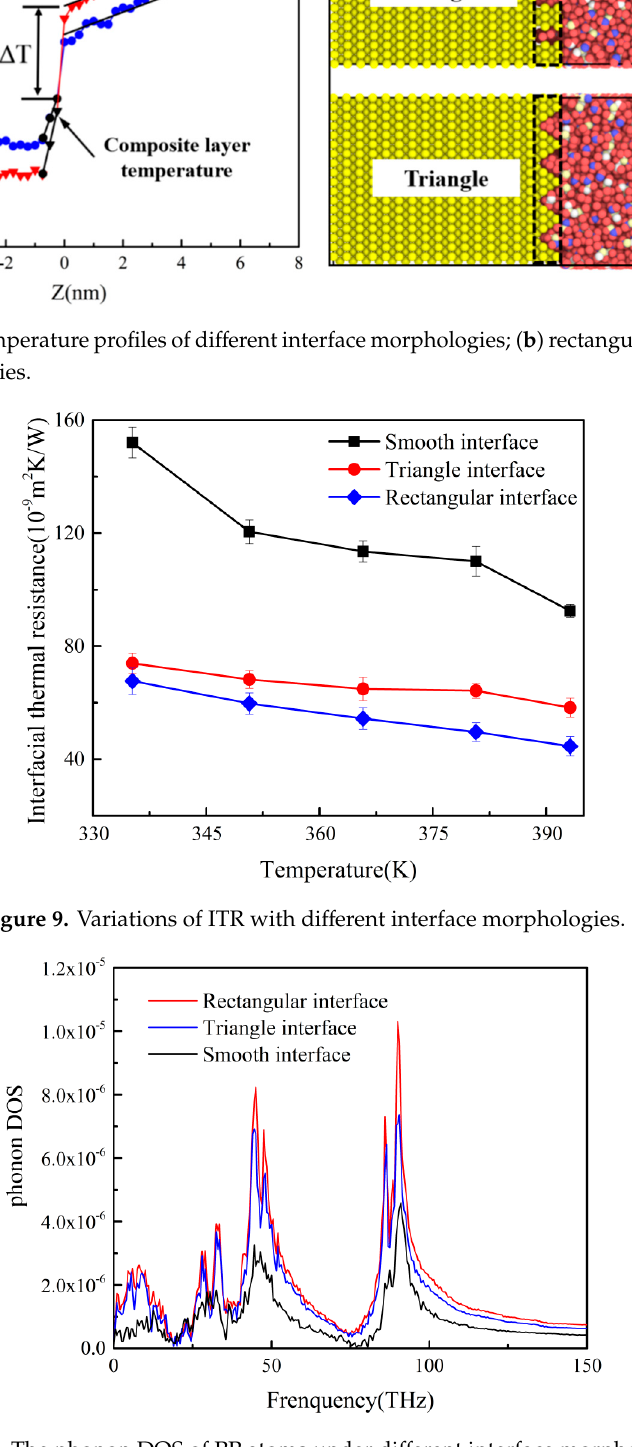
Figure 10. The phonon DOS of PP atoms under different interface morphologies.